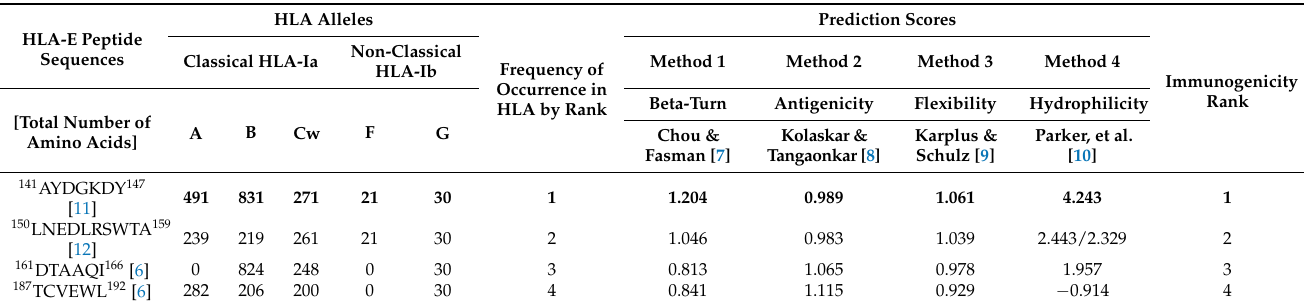
Table 3. Most commonly shared and cryptic peptide sequences in the α 2-domain of the heavy chains of all HLA-I isoforms (HLA-A/-B/-C/-E/-F and -G).